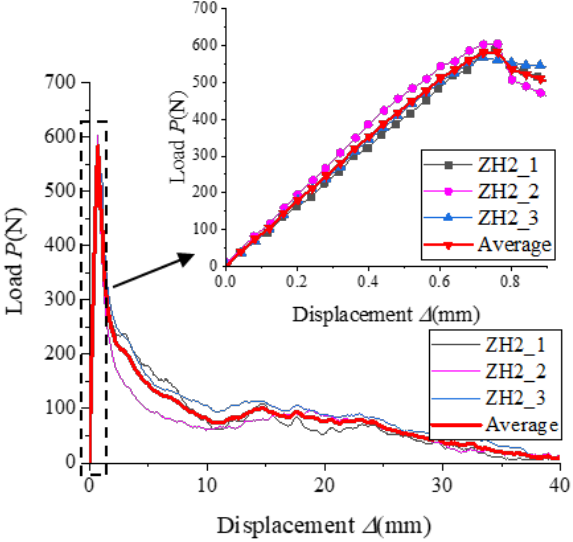
Figure 5. Pullout P - ∆ curves: steel fibres treated by Z6020 + H 2 ZrF 6 (group ZH2).